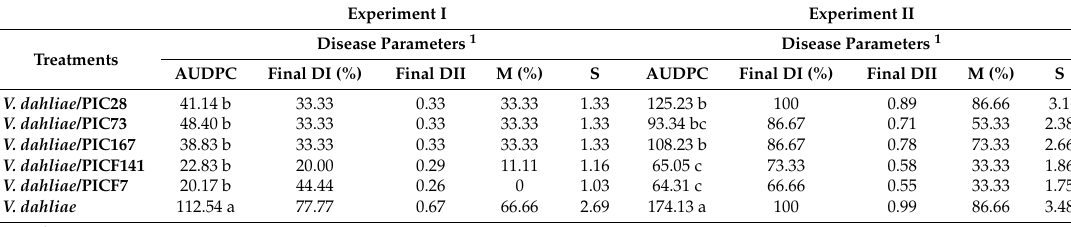
Biocontrol performance of Bacillales members against the defoliating pathotype of Verticillium